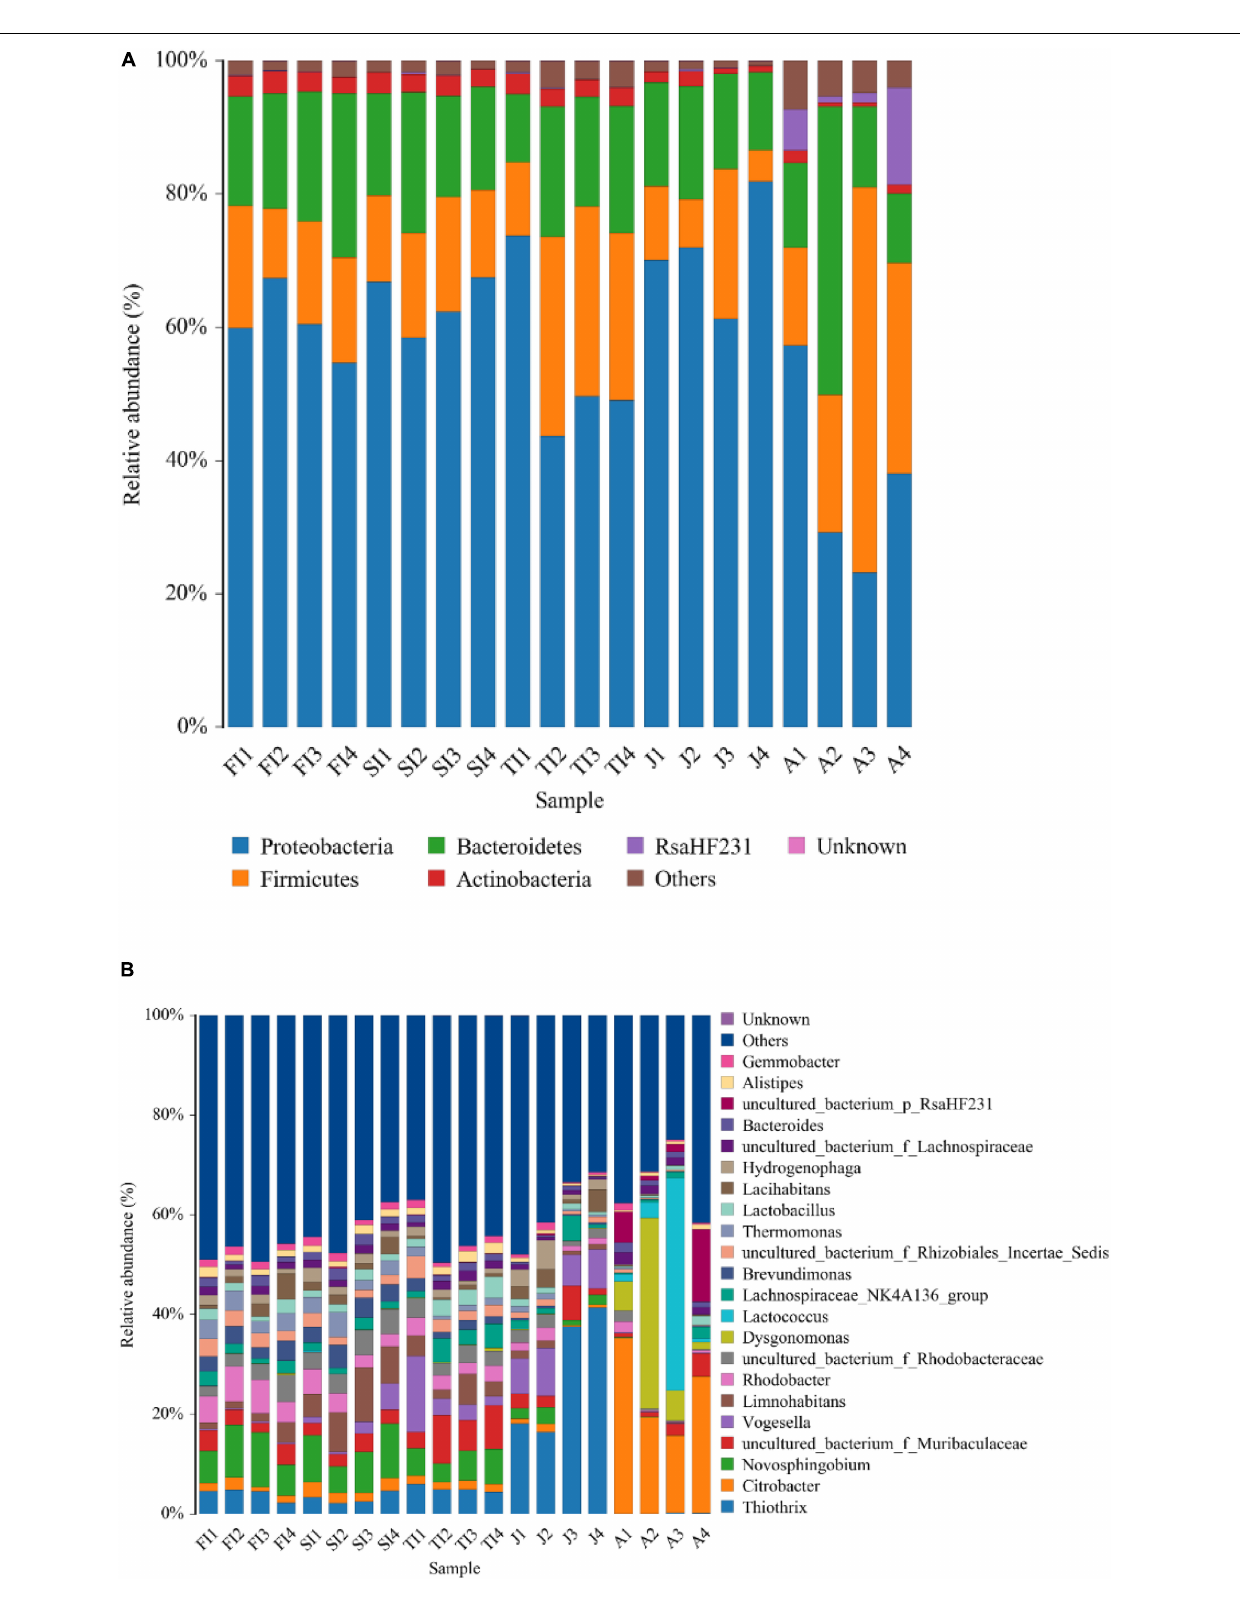
Frontiers in Microbiology |